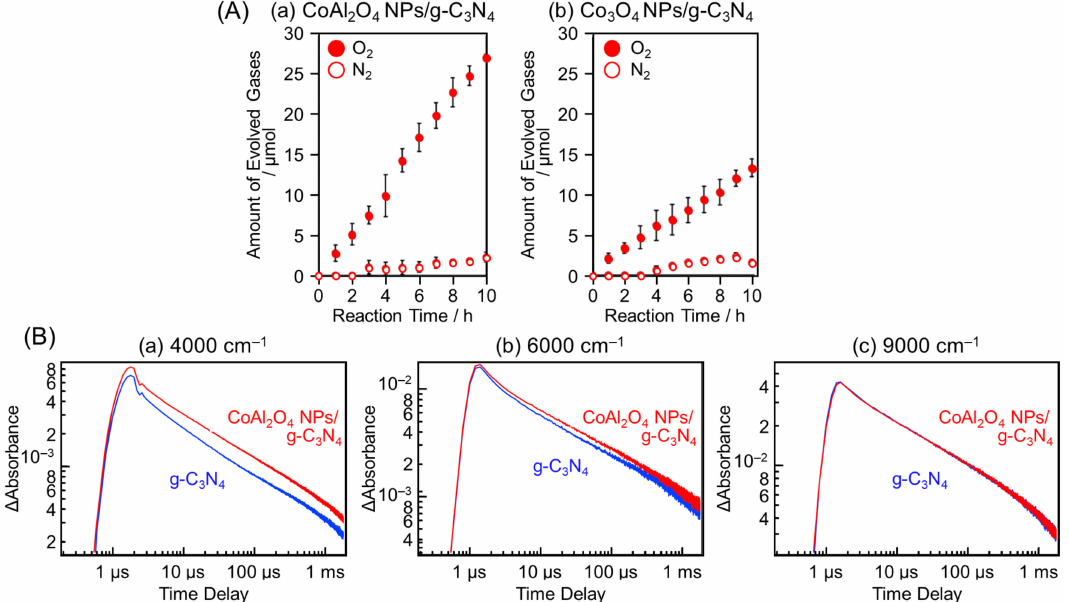
Figure 31. ( A ) Time course of photocatalytic O 2 evolution over g-C 3 N 4 loaded with ( a ) CoAl 2 O 4 (3.0 wt%) NPs and ( b ) Co 3 O 4 (1.5 wt%) NPs cocatalysts. Reaction conditions: catalyst, 50 mg; La 2 O 3 , 200 mg; reactant solution, aqueous AgNO 3 (10 mM, 140 mL); light source, 300 W Xe lamp